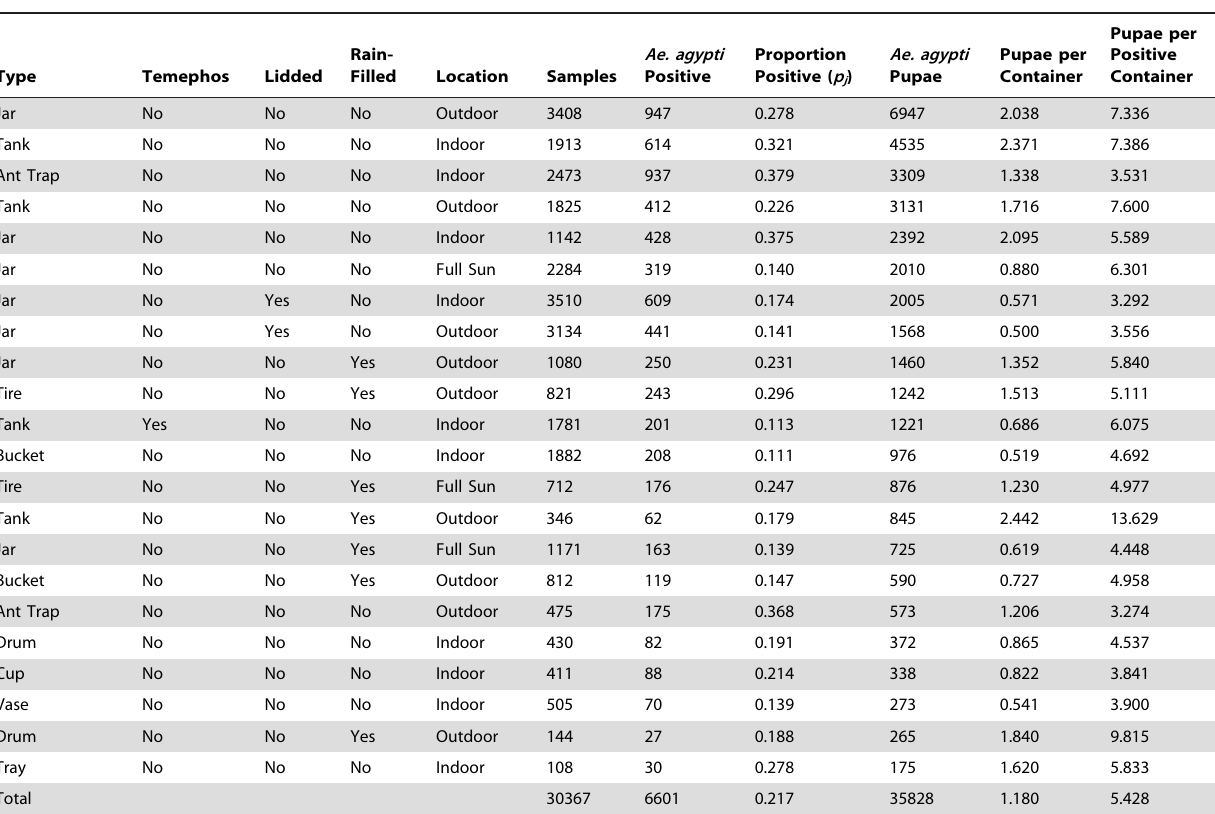
Table 1. The 22 key container classifications ordered by total Ae. aegypti